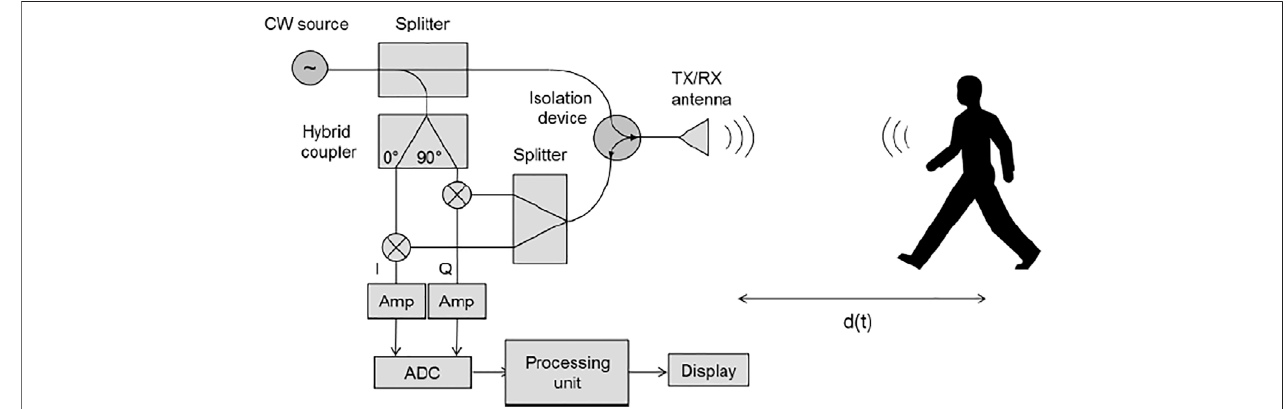
FIGURE 1 | CW radar system architecture.